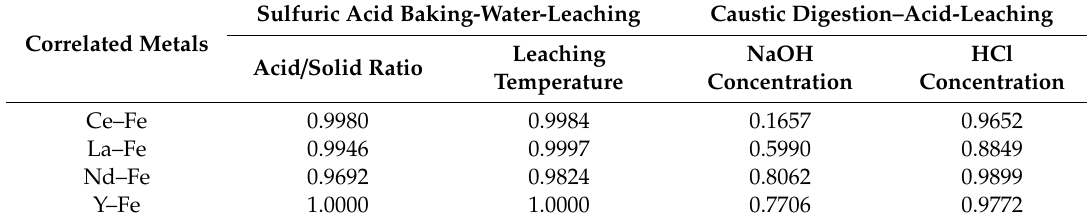
Table 5. R 2 values of REE–Fe correlation curves based on the decomposition method and leaching condition.